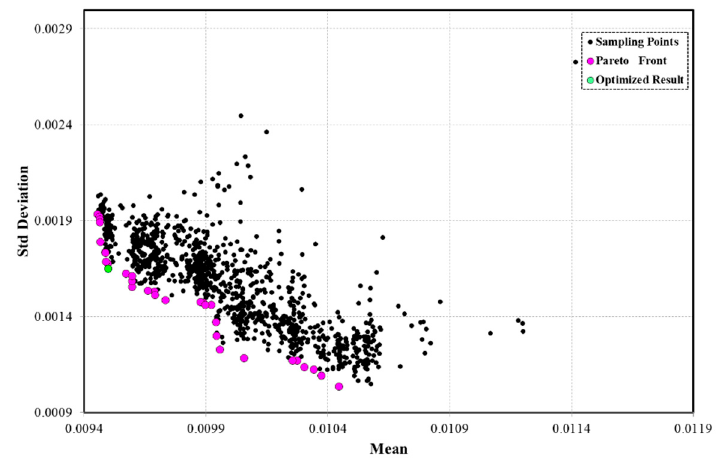
Figure 17. Robust optimization pareto front based on uniform probability distribution.